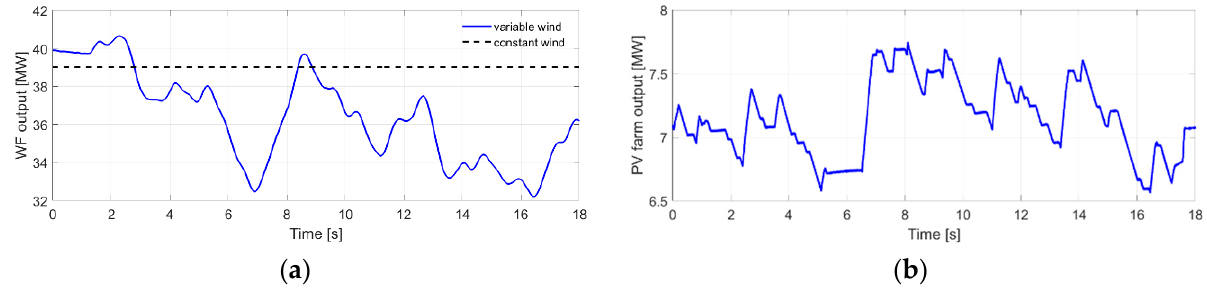
Figure 11. Output power: ( a ) wind farm under conventional operation; ( b ) PV farm under conventional operation.